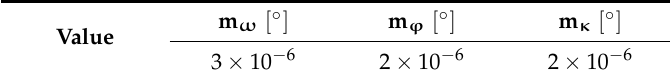
Table 8. Accuracy of exterior (angular) orientation of sensor in laboratory tests (on simulated data)—maximum deviation (errors) according to relation (23).